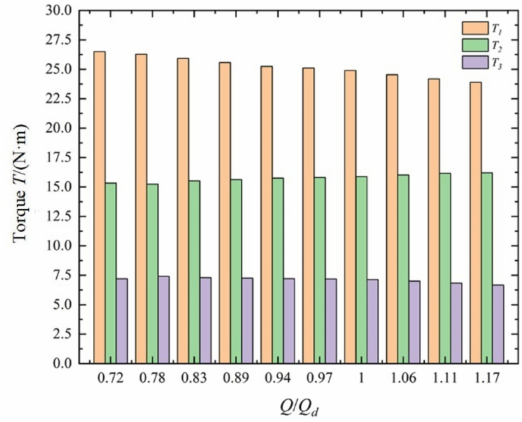
Figure 11. The torque variation of each part torque.